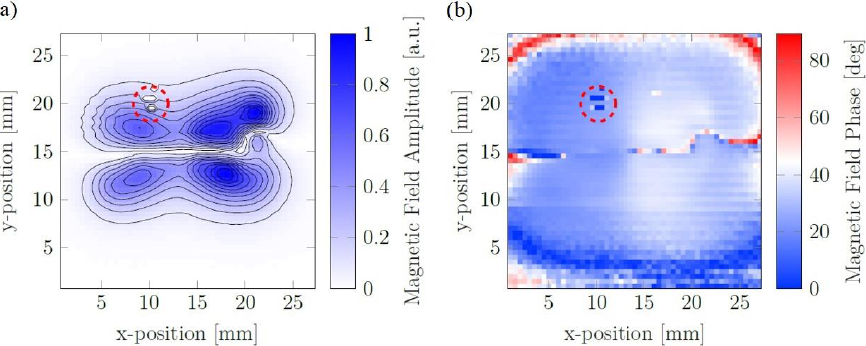
Figure 6. ( a ) Measured amplitude and ( b ) absolute value of the phase mod for the magnetic fields of the MNP distribution. the MNP